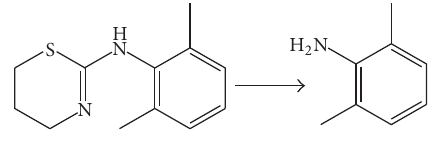
Figure 1: The structures of xylazine and